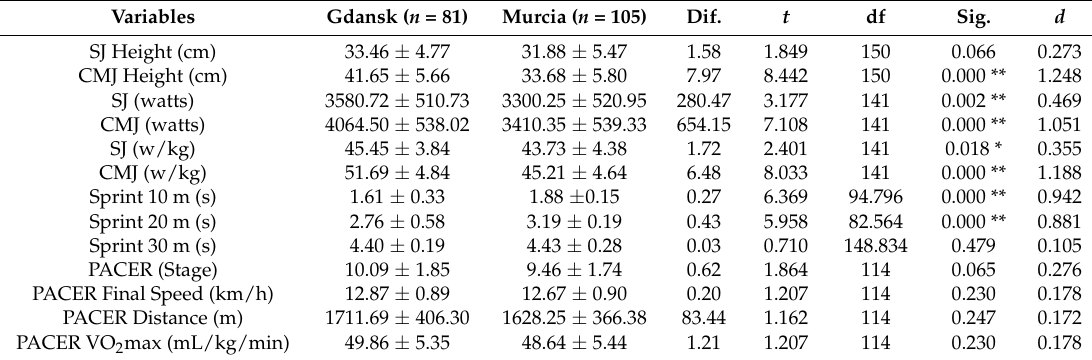
Table 2. Comparison of physical fitness of males from Gdansk and